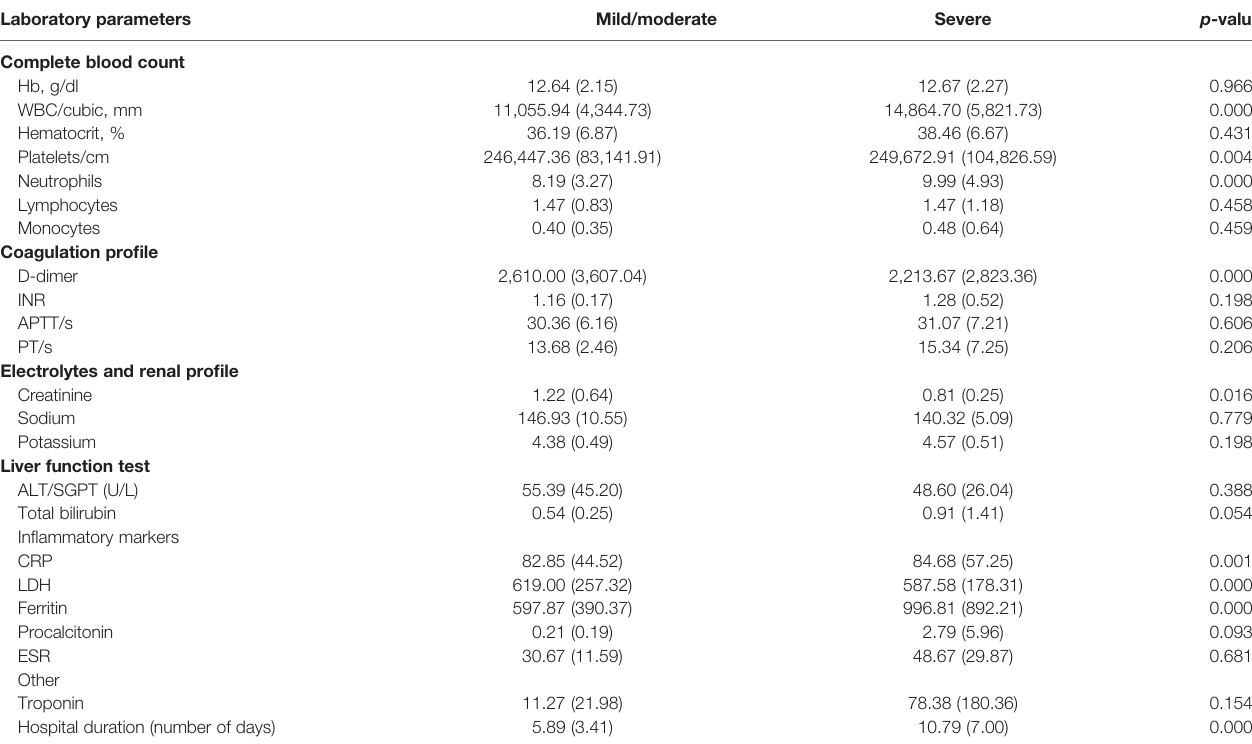
TABLE 4 | Laboratory features of 452 symptomatic COVID-19 patients.